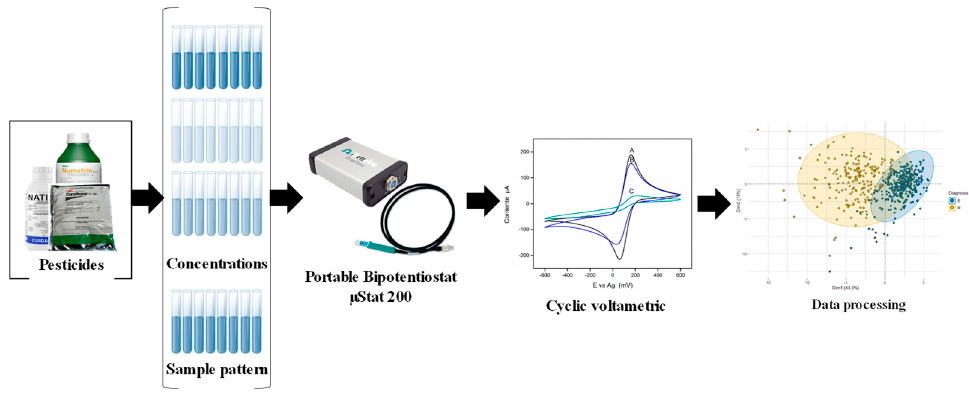
Figure 1. Overall scheme of the study based on an electronic tongue to detect pesticide types and concentrations in water.